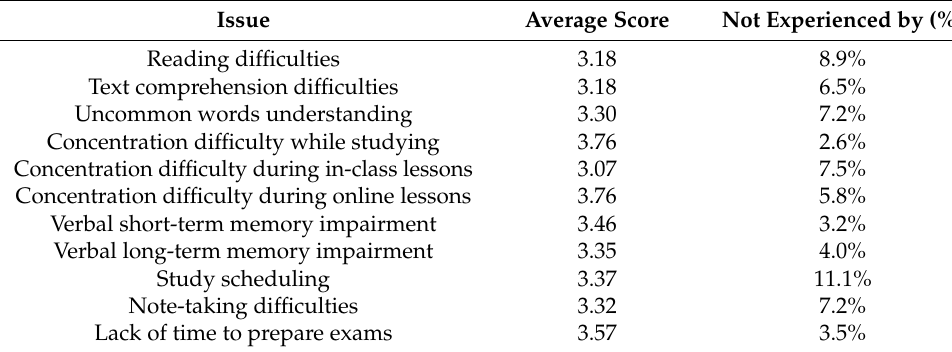
Table 5. Average score of the experiencing of dyslexia-related issues, given by the students in the questionnaire, from 1 (very little experienced) to 5 (very much experienced) and percentage of students that has not experience